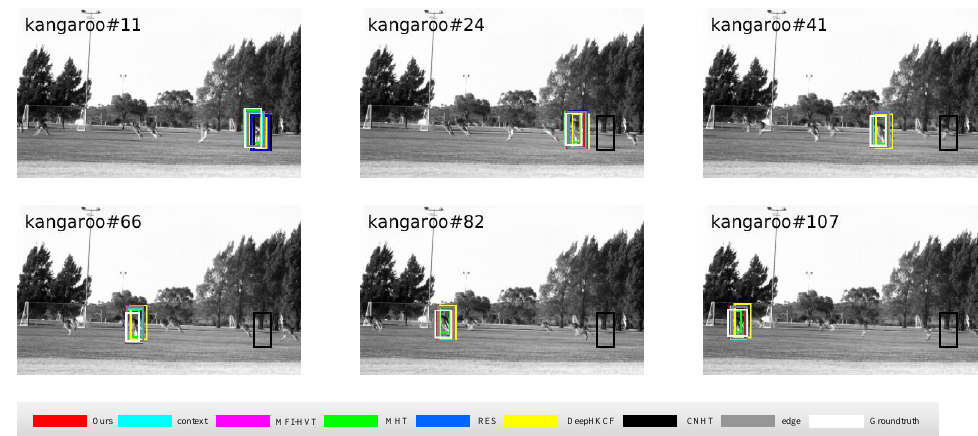
Figure 14. Qualitative outcomes for the kangaroo sequence. In Figure 15, the drive moves over a cluttered background, causing the drive to deform due to directional shifts. During the tracking process, the target changes frequently, causing the fact that the target boxes of all trackers do not adapt well to the changes of the target. However, at frame 599, our tracker overlaps perfectly with the ground truth.